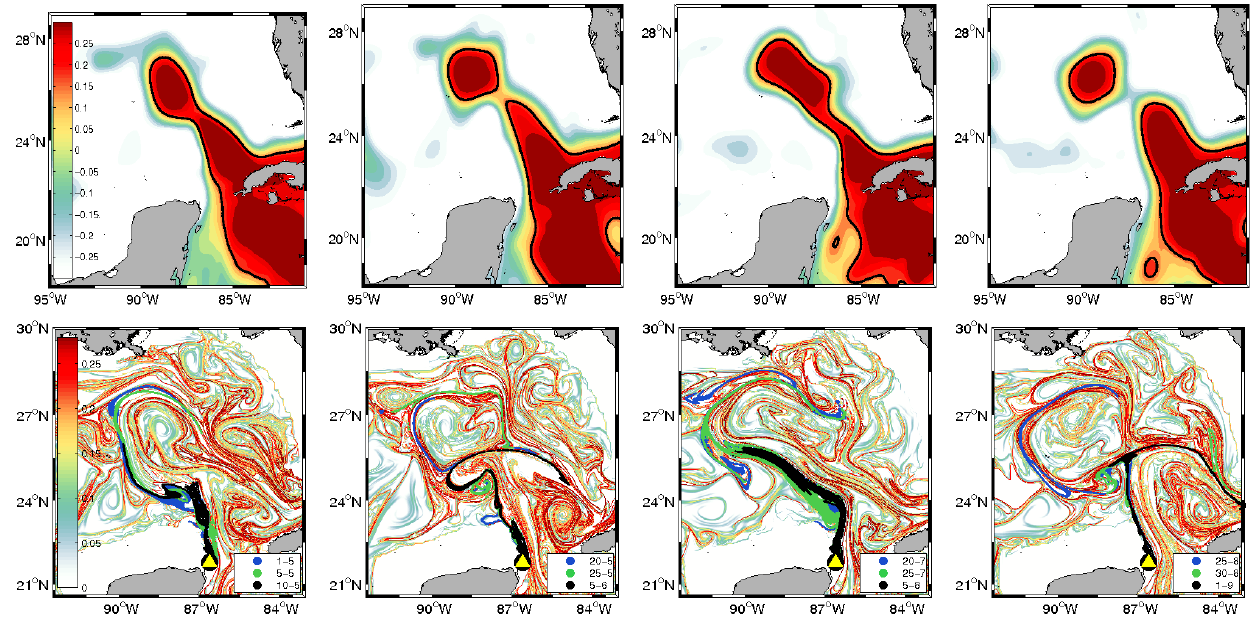
Fig. 4. Snapshots of SSH fields in m (top panel) and FTLE fields in d − 1 (lower panel) for the days indicated in Fig. 6a: 19 May, 9 June, 9 August and 15 September. The SSH field in the second column shows a detached LCE while the FTLE is highly structured and the YR still wraps around the LCB. Most of the particles (blue to black dots, the color indicates the day in which they are settled; marked in the bottom of each snapshot) seeded on the left corner of the Yucatan Peninsula go north following the YR, (yellow triangle) indicating the eddy is still attached. Finally, in the last panel, a substantial number of particles travel directly to the east following the YR, signalling that the LCE is totally separated. (see text)